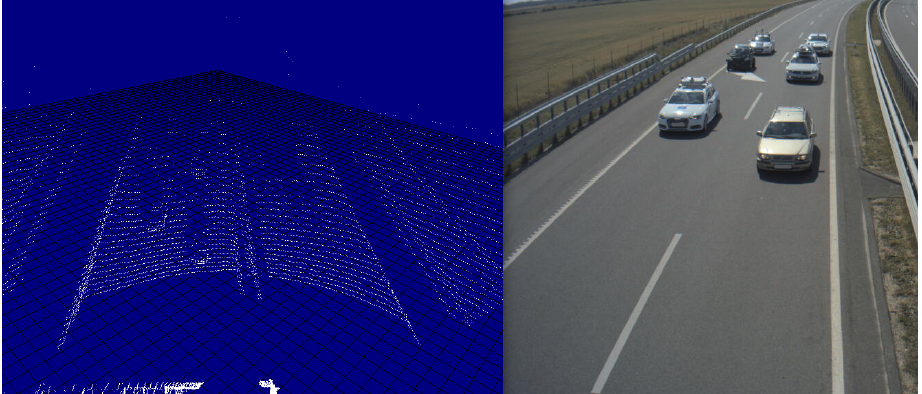
Figure 27. LIDAR point cloud ( left ) and camera image ( right ) from the same moment of